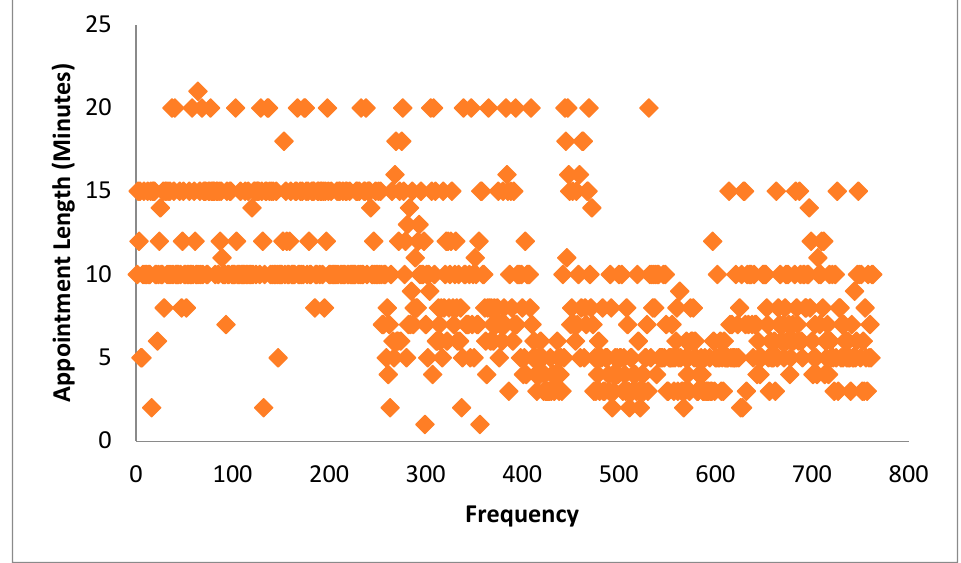
Figure 2. Frequency distribution of appointment length of medical consultations. Table 2. Patients’ socio-demographic, cognitive and predisposing predictors and doctors’ predis- posing predictors of longer appointment length in medical consultations.